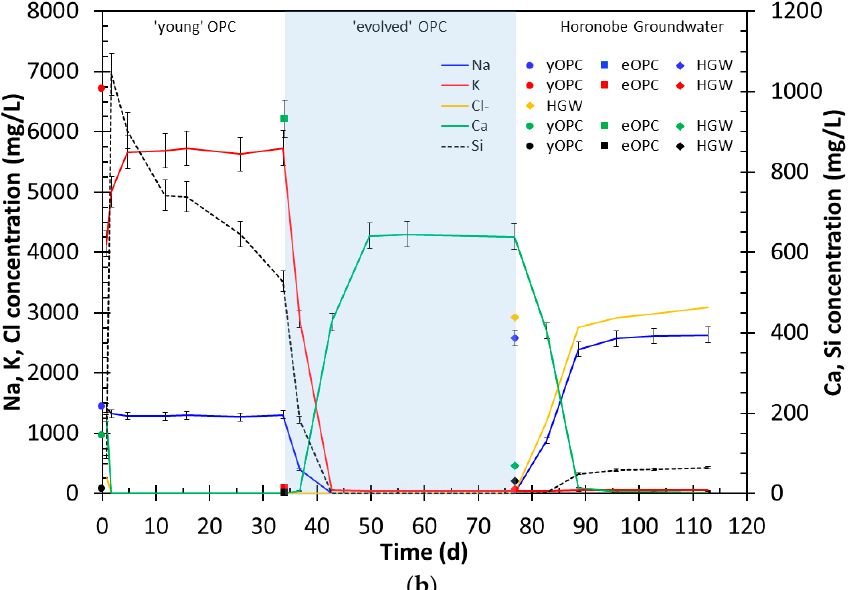
Figure 4. Major changes in fluid chemistry with time. Horonobe mudstone with ‘young’ OPC, and then the ‘evolved OPC leachate followed by HGW. ( a ) pH; ( b ) [Na], [K], [Ca], [SiO 2 ], and [Cl]. Legend text: yOPC—‘young’ OPC leachate; eOPC—‘evolved’ OPC leachate; HGW—Horonobe groundwater. Lines indicate concentrations in reacted samples; single points the original concentration in the reacting fluids.